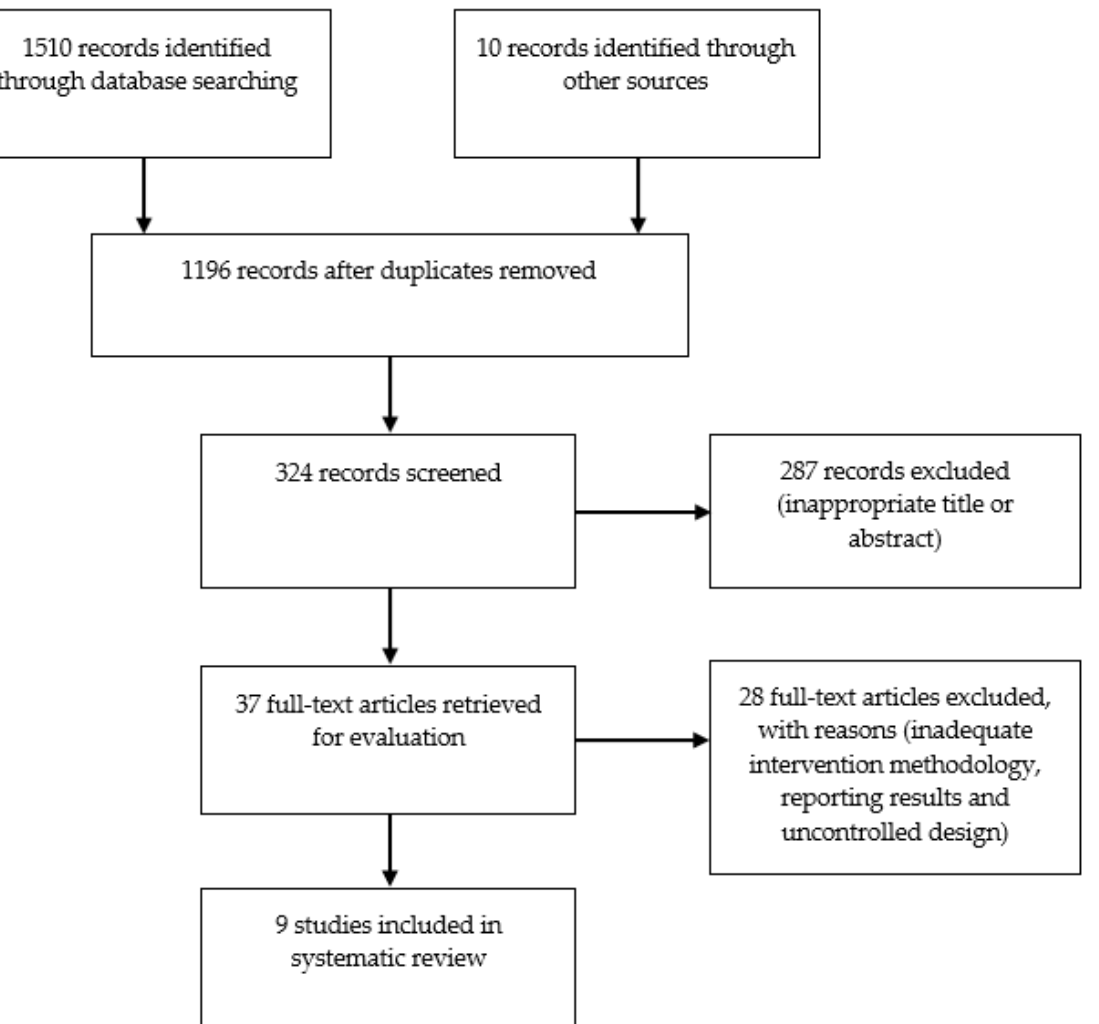
Figure 1. Flow diagram detailing the search strategy.